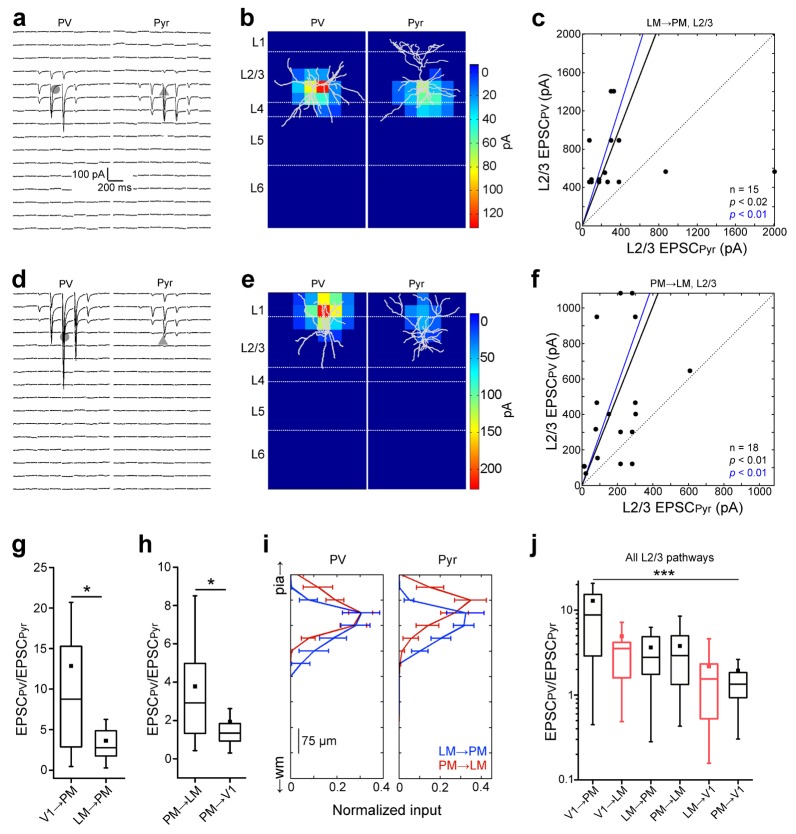
Interareal recruitment of L2/3 PV cells depends on the pathway and the hierarchical distance between areas.(a) EPSCssCRACM in a L2/3 PV (left) and Pyr (right) cell in the FFLM→PM pathway. (b) sCRACM map of EPSCs in 5a with reconstructed neuron positions. (c) Scatter plot of all PV-Pyr cell pairs in the L2/3 FFLM→PM pathway. PV cells exhibit larger currents than Pyr cells. (d–f) Similar data as in (a–c) but for the L2/3 FBPM→LM pathway. Note stronger L1 input in this pathway. (g) PV cell excitation, normalized to that of a neighboring Pyr cell, is stronger in the FFV1→PM than in the hierarchically shorter FFLM→PM pathway (*p<0.05, Mann-Whiteney U-test). (h) Normalized PV cell excitation is stronger in the FBPM→LM than in the hierarchically longer FBPM→V1 pathway (*p<0.05, Mann-Whiteney U-test). (i) Normalized plot of the total current in each row of the 8 × 16 grid, plotted against row position. EPSCs normalized to total current in each cell-type. (j) The total EPSCssCRACM in a PV cell, normalized to the total EPSCssCRACM in a neighboring Pyr cell, depends on the directionality of the pathway and hierarchical distance between areas. Red boxes represent data describing connections between V1 and LM from Yang et al. (2013). ***p<0.001, Kruskal-Wallis test.